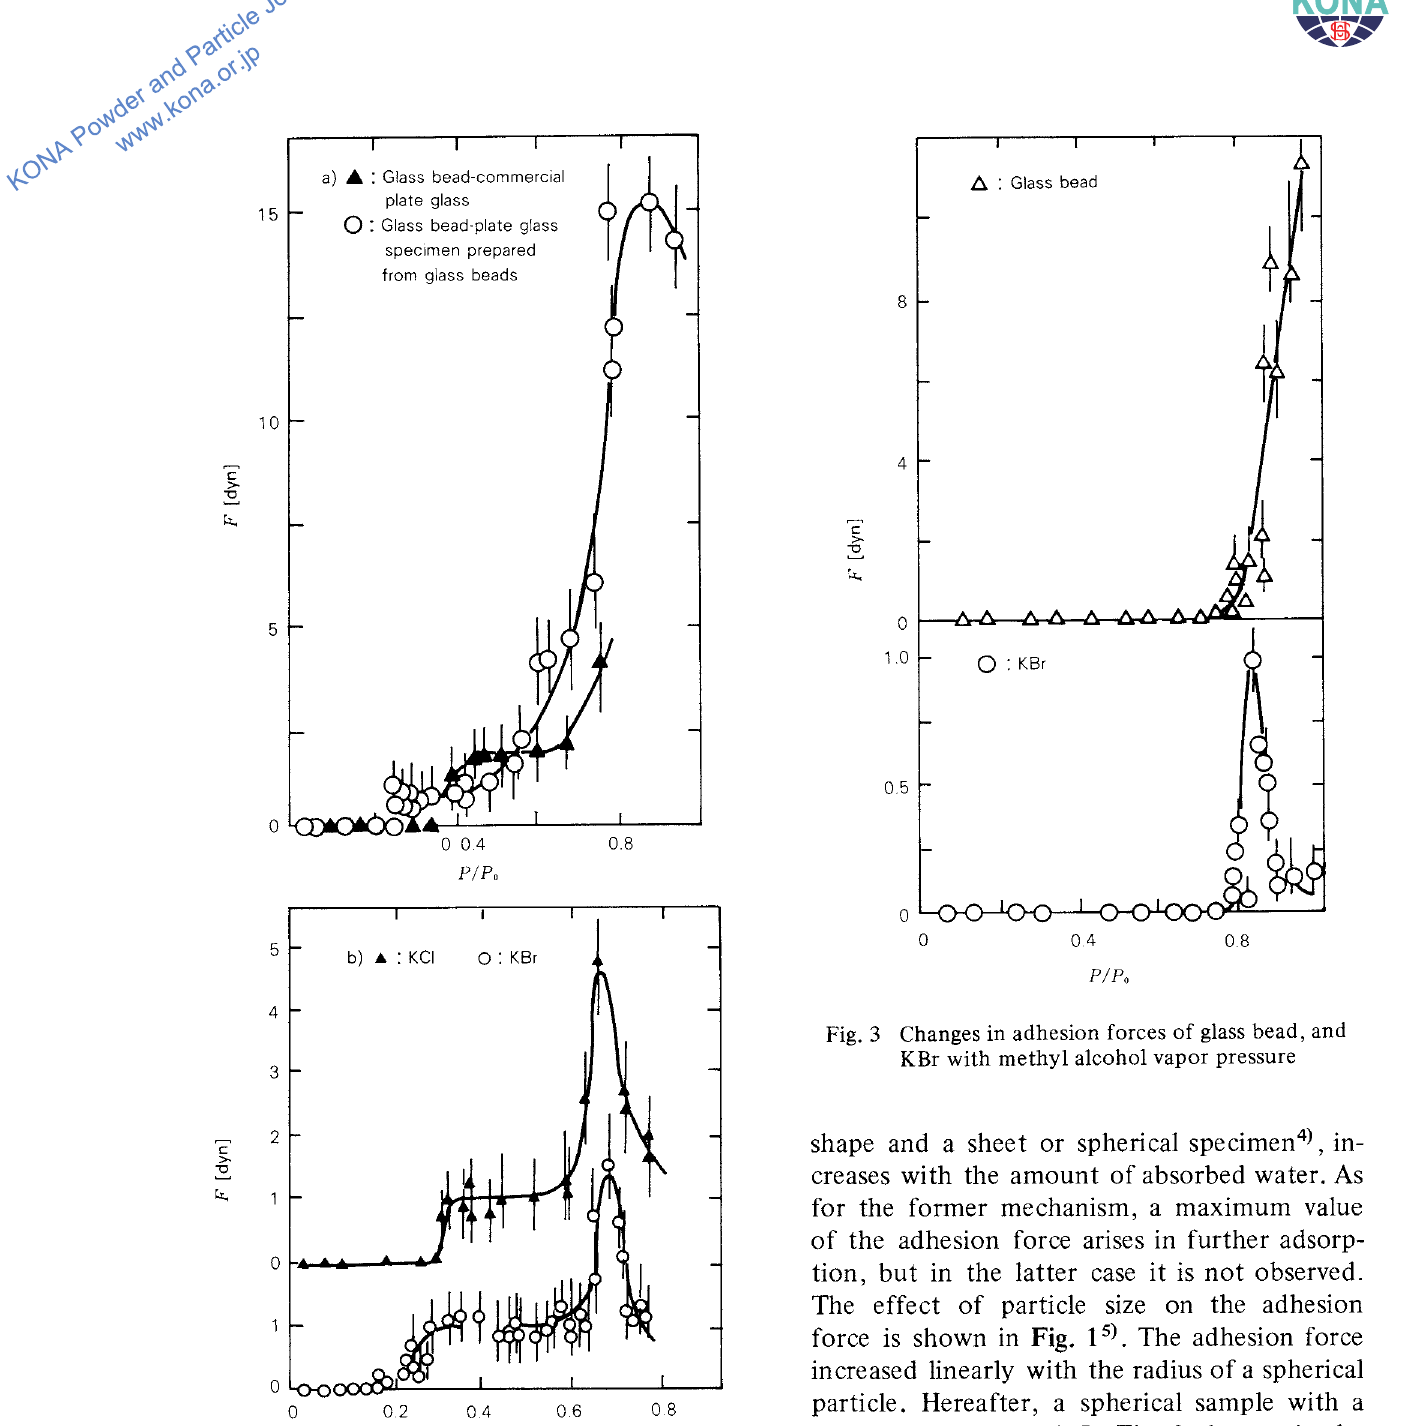
Fig. 2 Changes in adhesion forces of potassium halides at a contact point with water vapor pressure the mechanism of such adhesion force change are obtained. According to theoretical calcula tions, the adhesion force generated by a liquid bridge which is formed in a gap of the sepa rated two spherical particles 3 ) or made at a contact point between a projection of conical